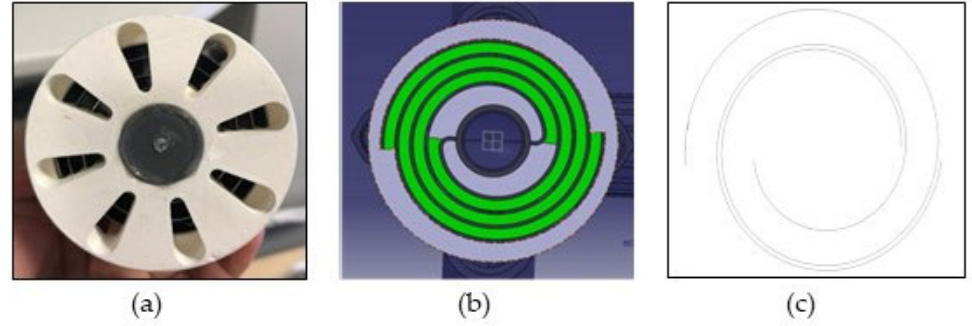
Figure 3. The spiral electrodes viewed: ( a ) through the end caps (left), ( b ) the effective electrocoagulation zone shaded in green (middle), and ( c ) the spiral electrodes geometry (right).